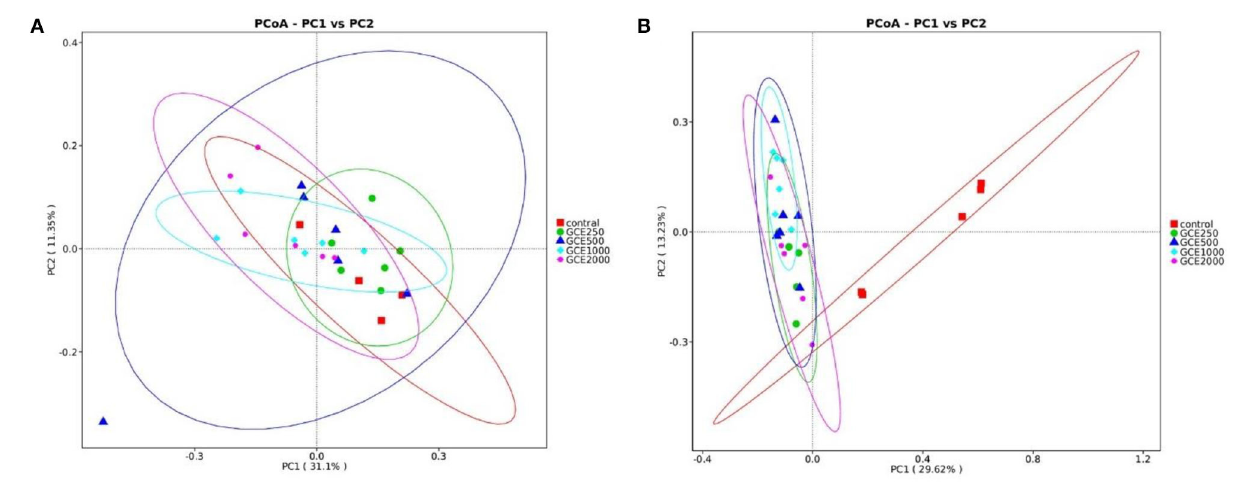
FIGURE 3 | Principle coordinate analysis (PcoA) of broiler cecal bacterial communities at genus level in different groups: (A) 28 days; (B) 60